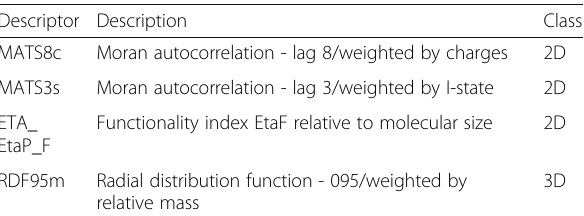
Table 6 Description and class of molecular descriptors in model